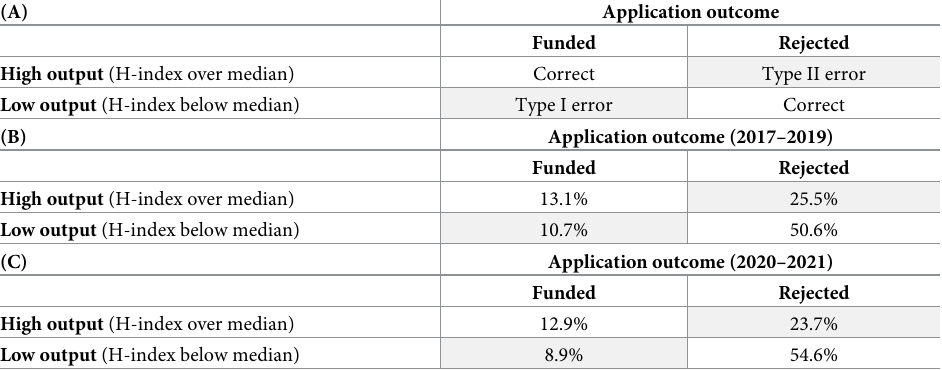
Table 1. Type I error and type II error when comparing the decision outcome and the applicant’s H-index before and after the introduction of the decision support tool. Overview of type I and type II errors (A), proportion of type I and type II errors between 2017–2019 (B) and proportion of type I and type II errors between 2020–2021 (C). For more details about type I and type II errors see